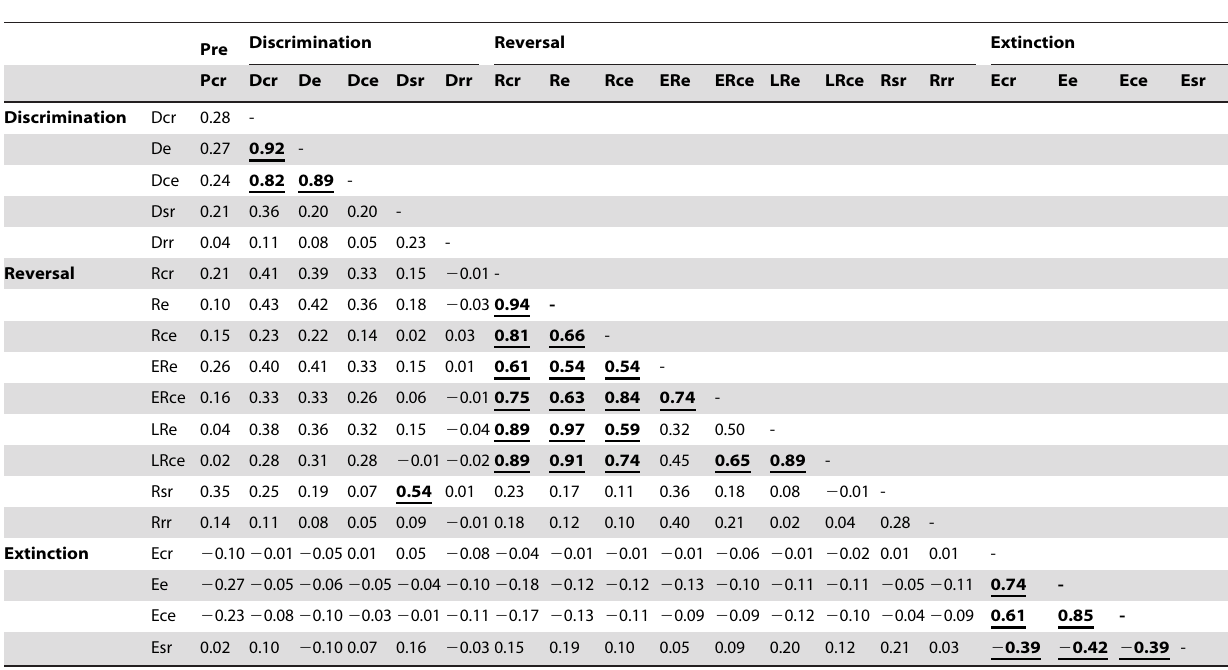
Table 1. Genetic correlations between measures of touchscreen performance and learning.